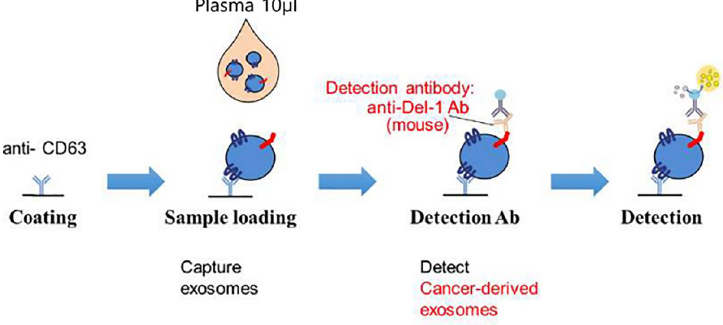
Fig 2. Enzyme-linked immunosorbent assay (ELISA) for detecting developmental endothelial locus-1 (Del-1)